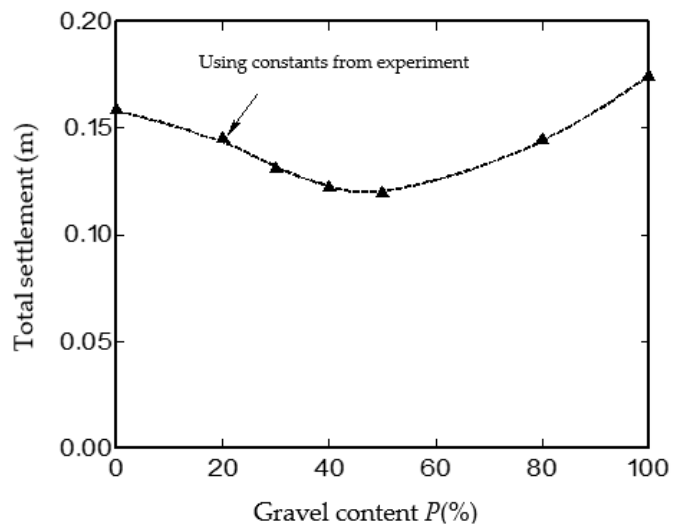
Figure 11. Total settlement of the embankment after completion using the constants obtained from the one-dimensional compression test.